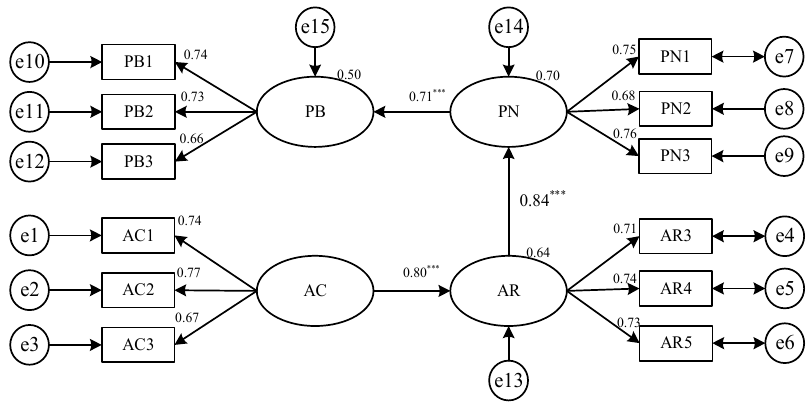
Figure 3. Competing model 2: NAM model. Note: *** is significant at 1%. Robust standard error in